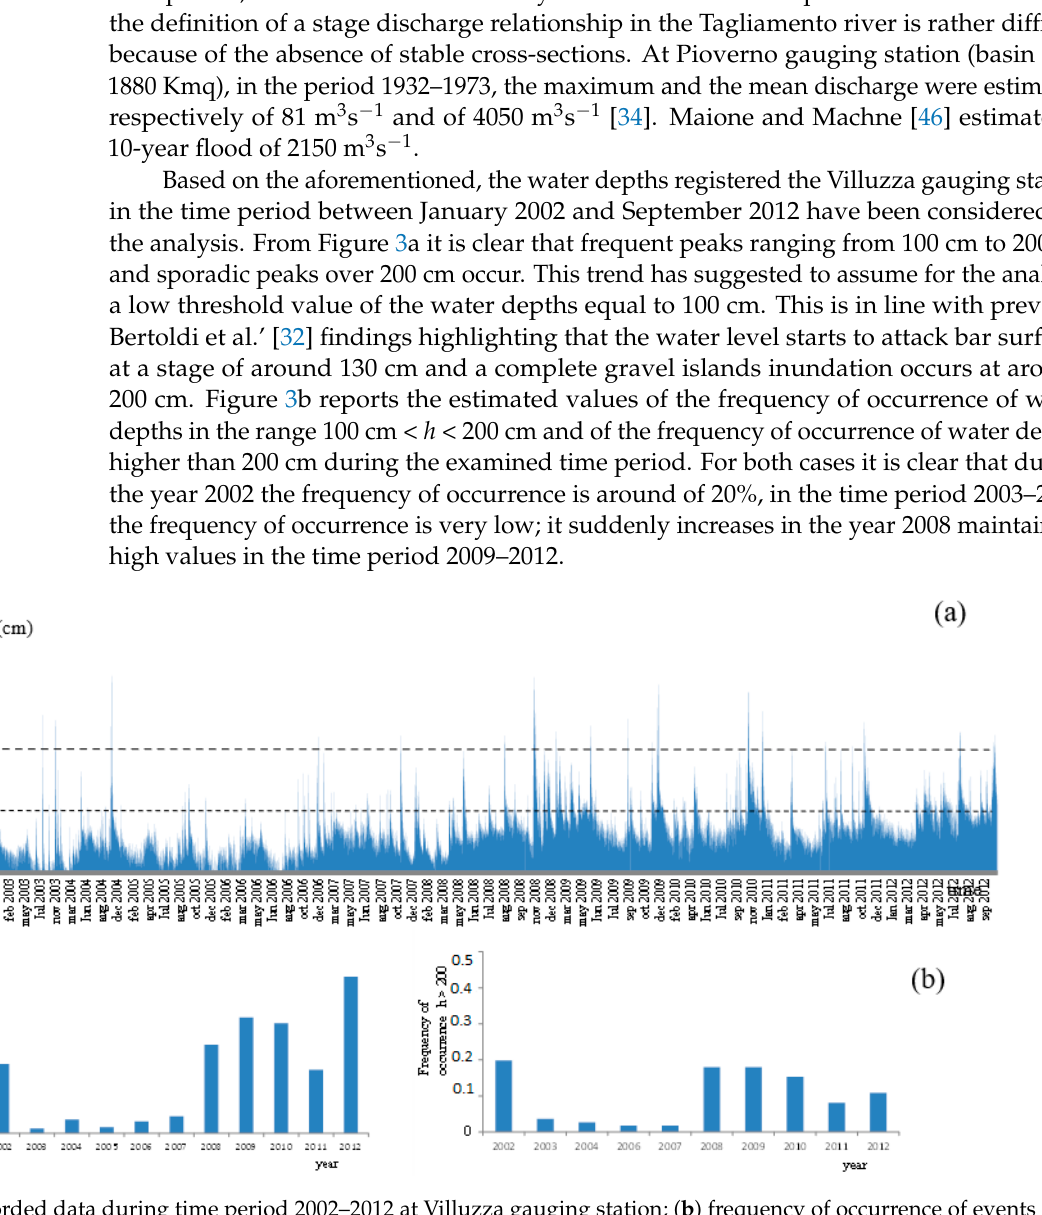
Figure 3. ( a ) recorded data during time period 2002 – 2012 at Villuzza gauging station; ( b ) frequency of occurrence of events with water depth 100 cm < h < 200 cm and of events with water depth h > 200 cm. Thus, it could be summarized that, while the time period 2003–2007 is characterized by relatively frequent low-magnitude events with sporadic peaks (as an example the events occurring in August 2003, in November 2003 and in October 2004, as Figure 3a shows), the time period 2008–2012 is characterized by frequent high-magnitude events. 2.3. Methods The extraction of information from each image was operated by the help of CAD and QGIS software. According to Gurnell [47], in order to minimize the errors in extracting information from the images representing different dates, some control points (such as corner of bridges or of buildings, specific rocks. etc.) clearly distinguishable inside the study area were identified and the images were extracted at the same scale. This was op- erated also with the help of the AirphotoSE free code for the images’ rectification. The existence of some control points enhances significantly Google Earth positional accuracy [48]. Furthermore, it should be considered that the examined area is around 1 Km 2 and for areas smaller than about 2 km 2 , the distortion of the images determines an error usually of the order of a meter or two [48]. This error is not too far from the error obtained by using other image-based techniques [34,40]. The procedure to take information was divided into three steps. In the first step, for each image the external boundary of the “active” area of the examined river reach was determined and digitized; thus, the boundary of the largest active area was obtained as the external intersection of the digitized active areas obtained at each time. The second step concerned the extraction of information regarding the active channels and the vege- tation patches. To this aim, the study reach was divided into subareas by transients spaced